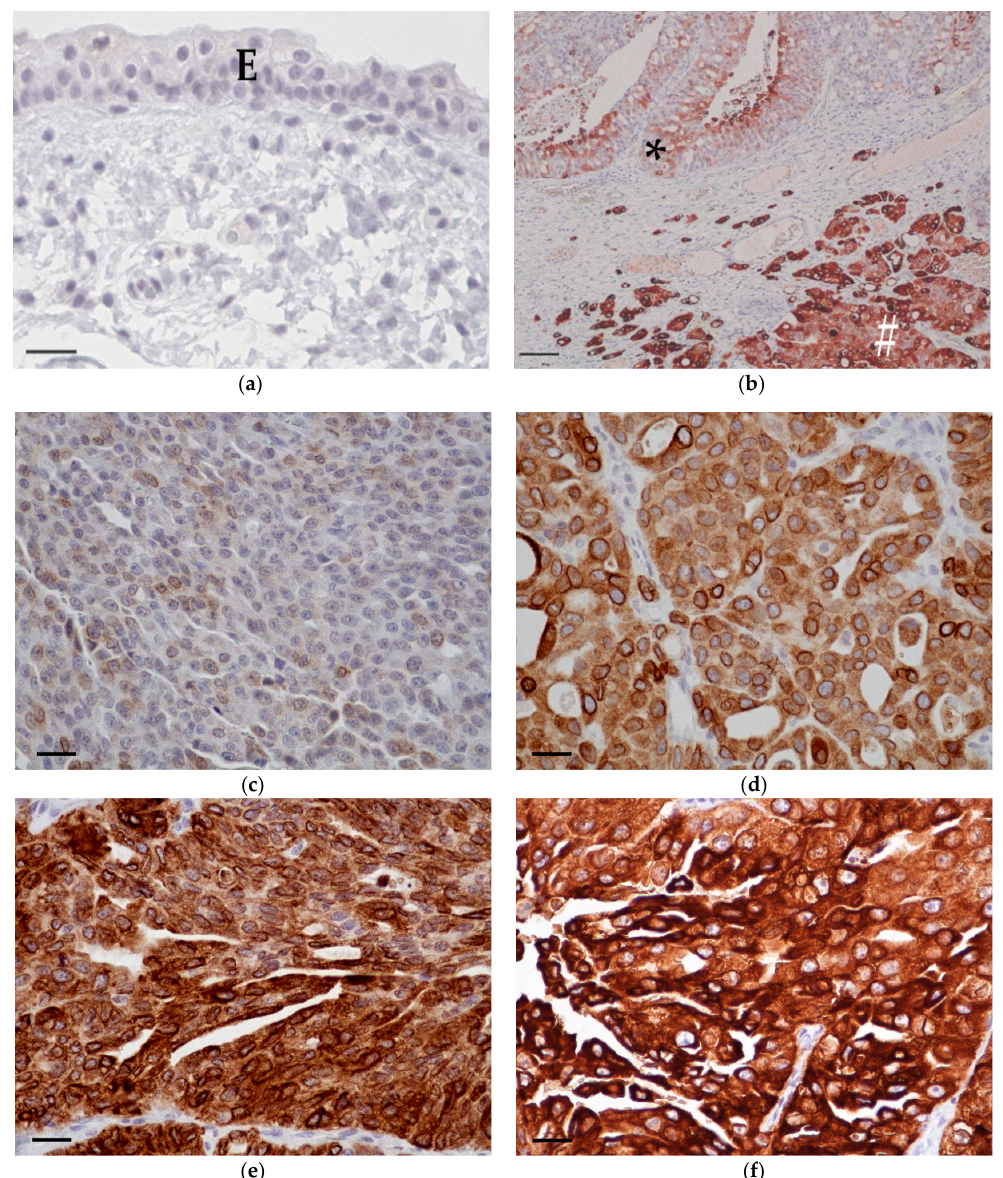
Figure 3. Cyclooxygenase-2 immunohistochemistry. ( a ) Normal bladder epithelium (E) of a 10-year-old female mongrel. There is no apparent cyclooxygenase-2 expression (COX-2, bar = 25 μ m). ( b ) High-grade transitional cell carcinoma from an 11-year-old female Scottish terrier with an IRS of 7.6. Intensity of cyclooxygenase-2 expression varied from mild (*) to marked (#) within the specimen (COX-2, bar = 100 μ m). ( c ) Area with minimal intensity of cyclooxygenase-2 expression in high-grade transitional cell carcinoma from an 11-year-old castrated female bracke (COX-2, bar = 25 μ m). ( d ) Area with mild intensity of cyclooxygenase-2 expression in low-grade transitional cell carcinoma from a 12-year-old castrated female beagle (COX-2, bar = 25 μ m). ( e ) Area with moderate intensity of cyclooxygenase-2 expression in high-grade transitional cell carcinoma from a 13-year-old castrated male mongrel (COX-2, bar = 25 μ m). ( f ) Area with marked intensity of cyclooxygenase-2 expression in low-grade transitional cell carcinoma from an 11-year-old castrated male podenco (COX-2, bar = 25 μ m).